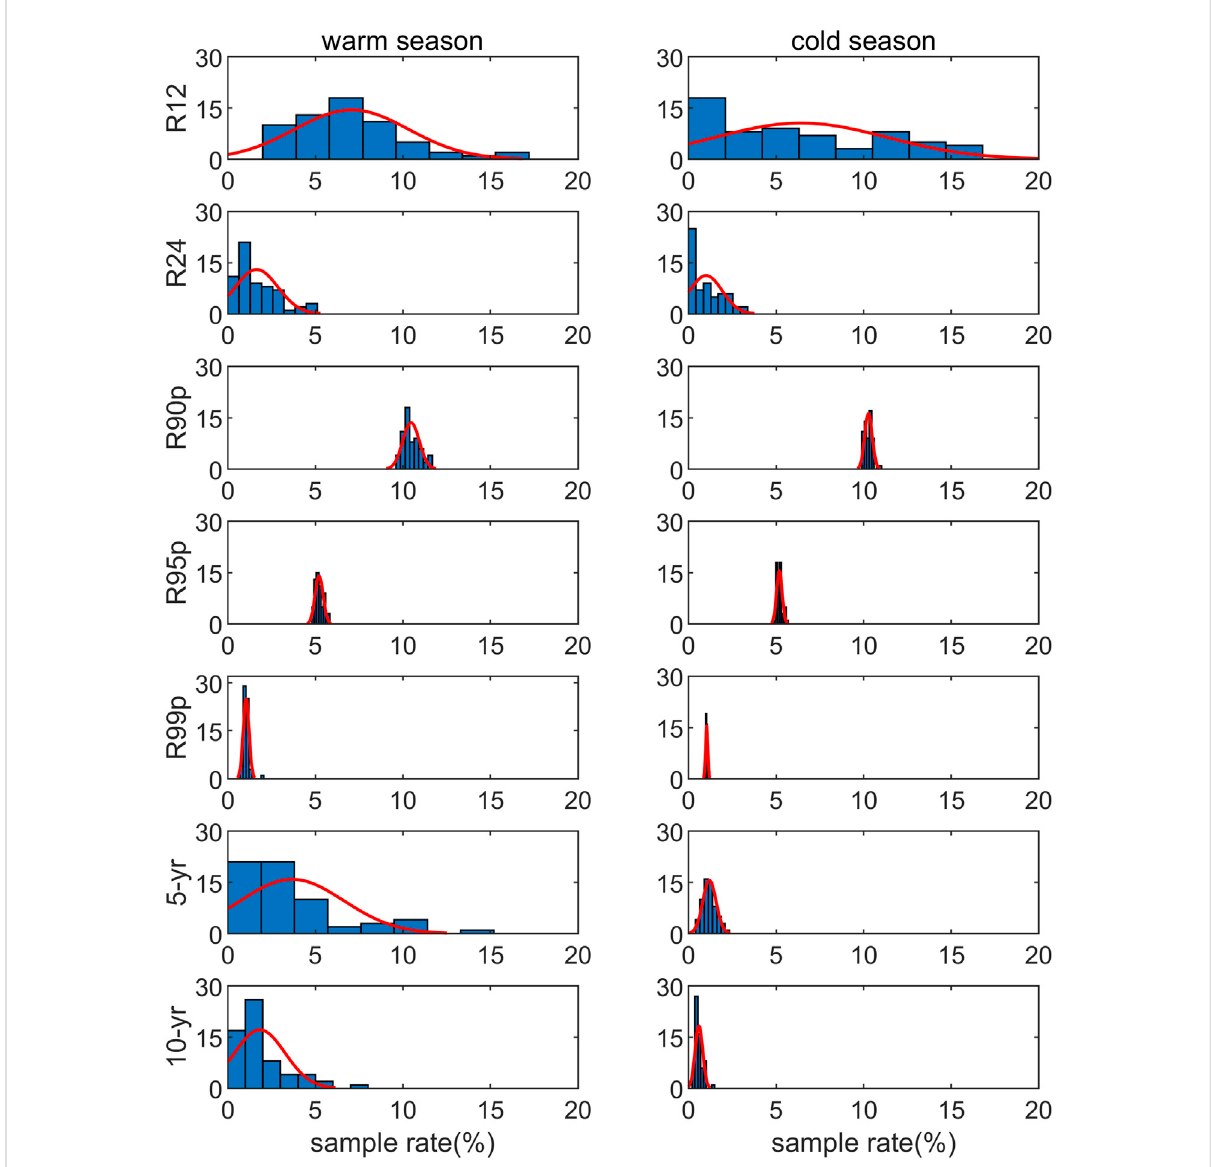
FIGURE 11 Thedistributionforthesamplerateofdifferentthresholdcriteriainmulti-stations(Bluebar:histogramofsamplerate;redline:distribution fi tby normal